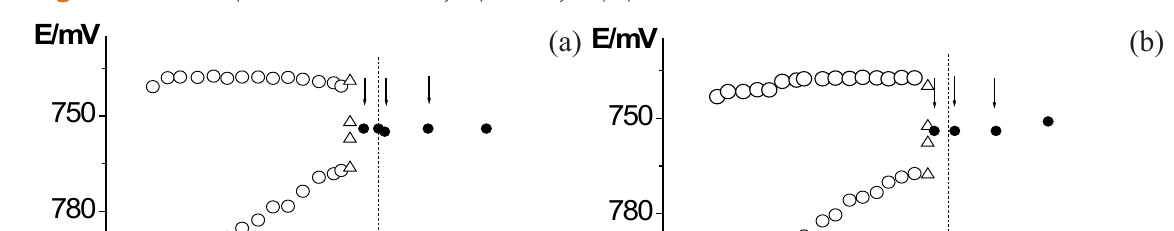
= 7.20×10 −2 mol L -1 (T = 55.0°C) A